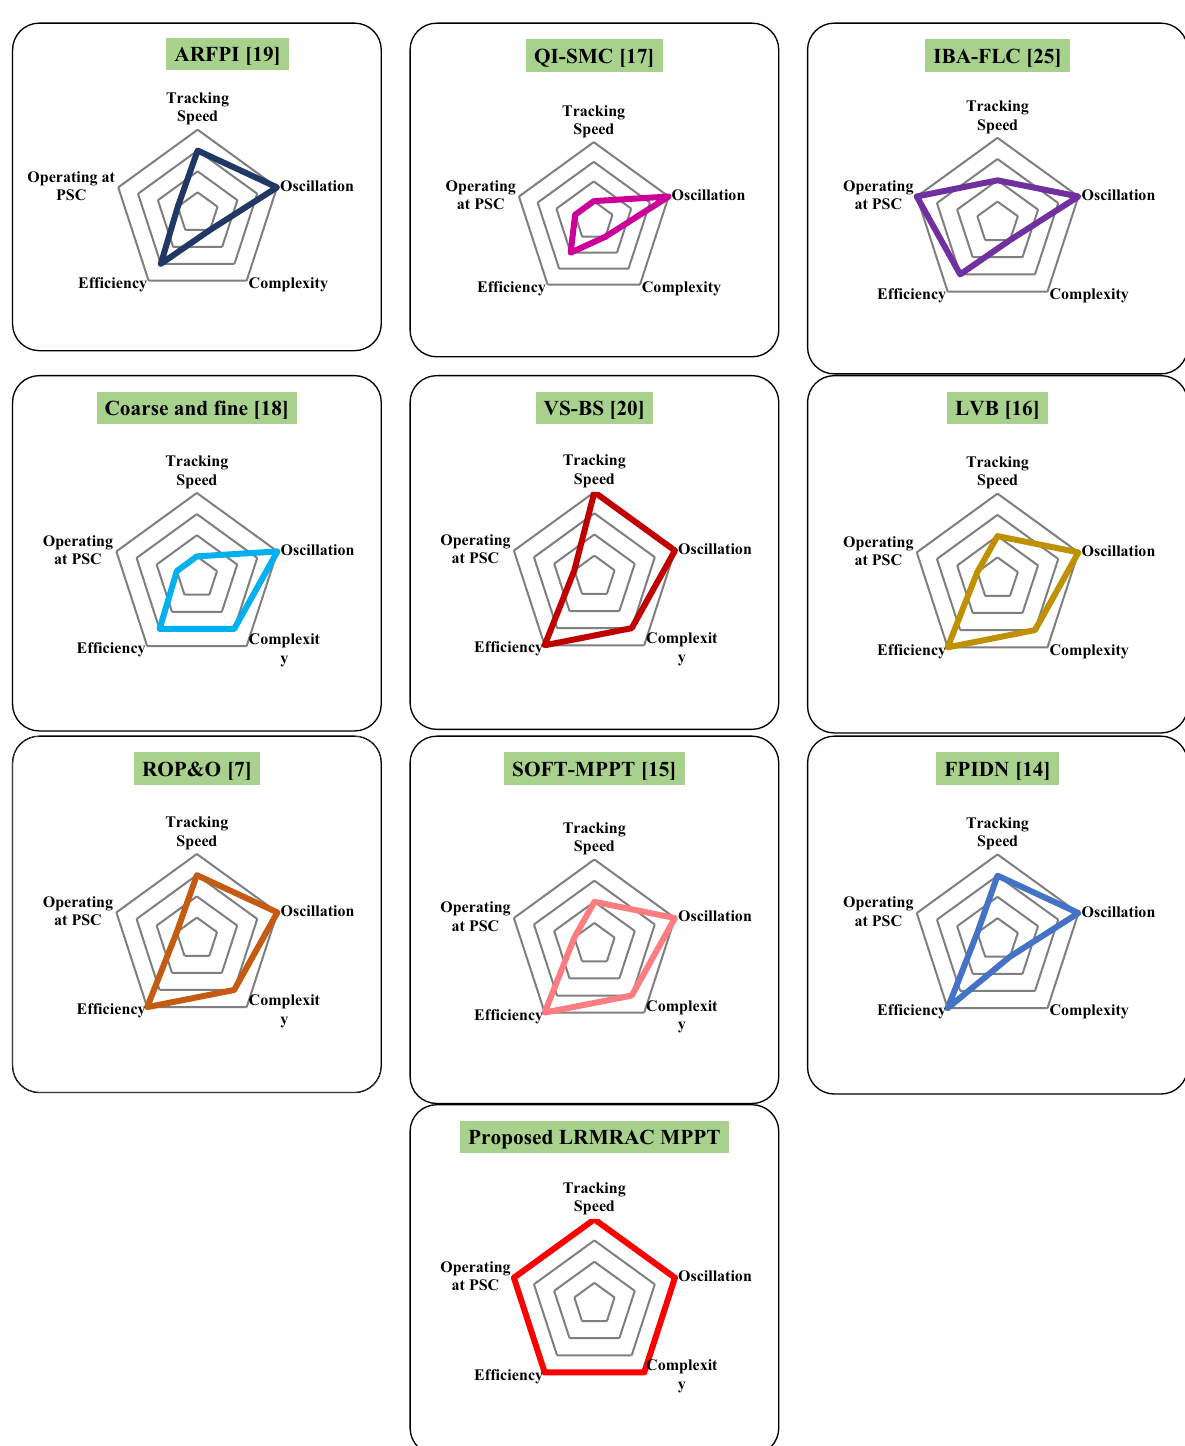
Fig. 28 Radar graphs demonstrating the performance comparison of the different cutting edge MPPT